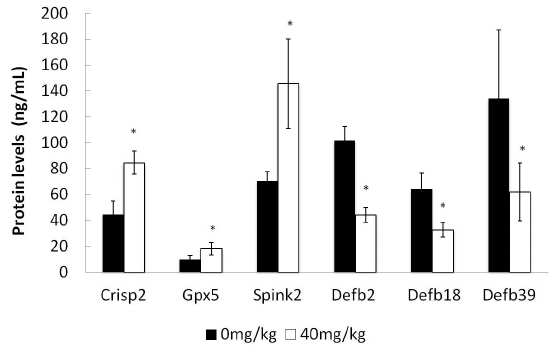
Figure 7. Analysis of proteins concentration data between dutasteride-treated group and control group by ELISA in epididymal luminal fluids. * p < 0.05 versus the control